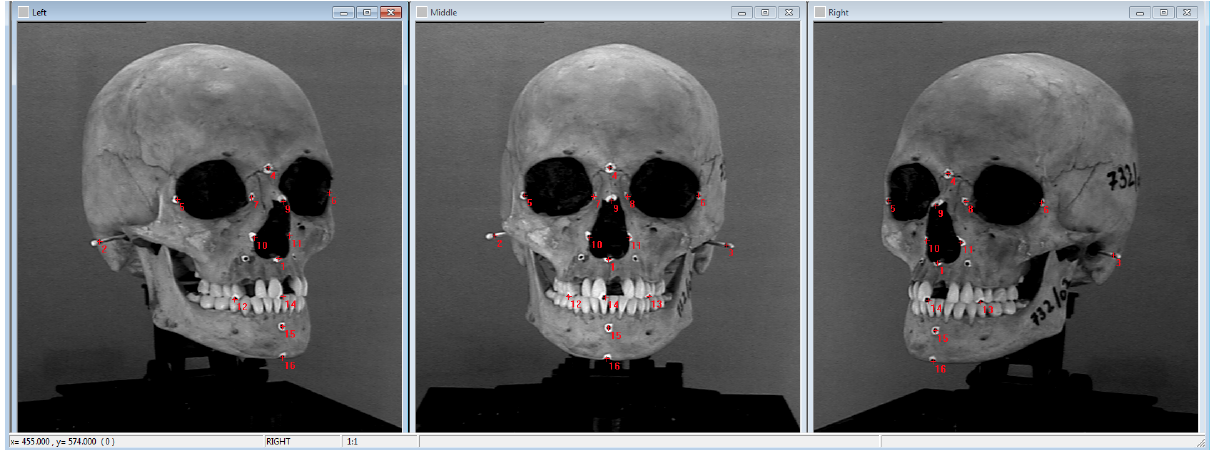
Figure 5. Three oriented images of a skull with manually marked craniometric landmarks